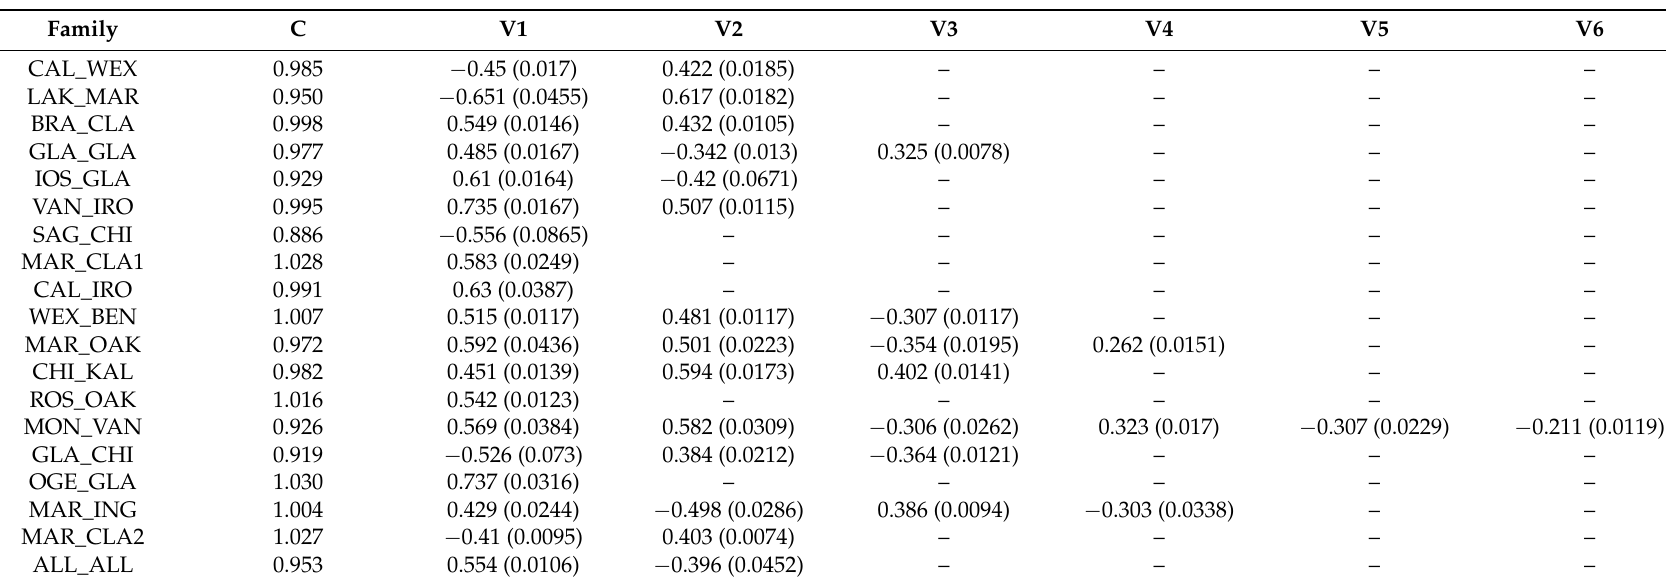
Table 3. Coefficients of regression models relating radial growth of hybrid aspen families to climate moisture index variables. Climate variables (V) are identified in Figure